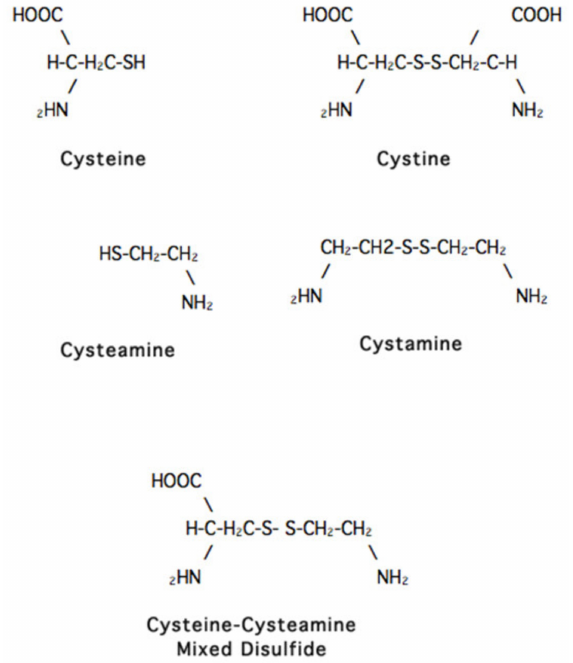
Figure 2. Structures of compounds mentioned in this article. The two compounds shown on the upper left are sulfhydryls because they have a -SH group. The compounds to their right are disulfides. The compound at the bottom is a mixed disulfide of two different